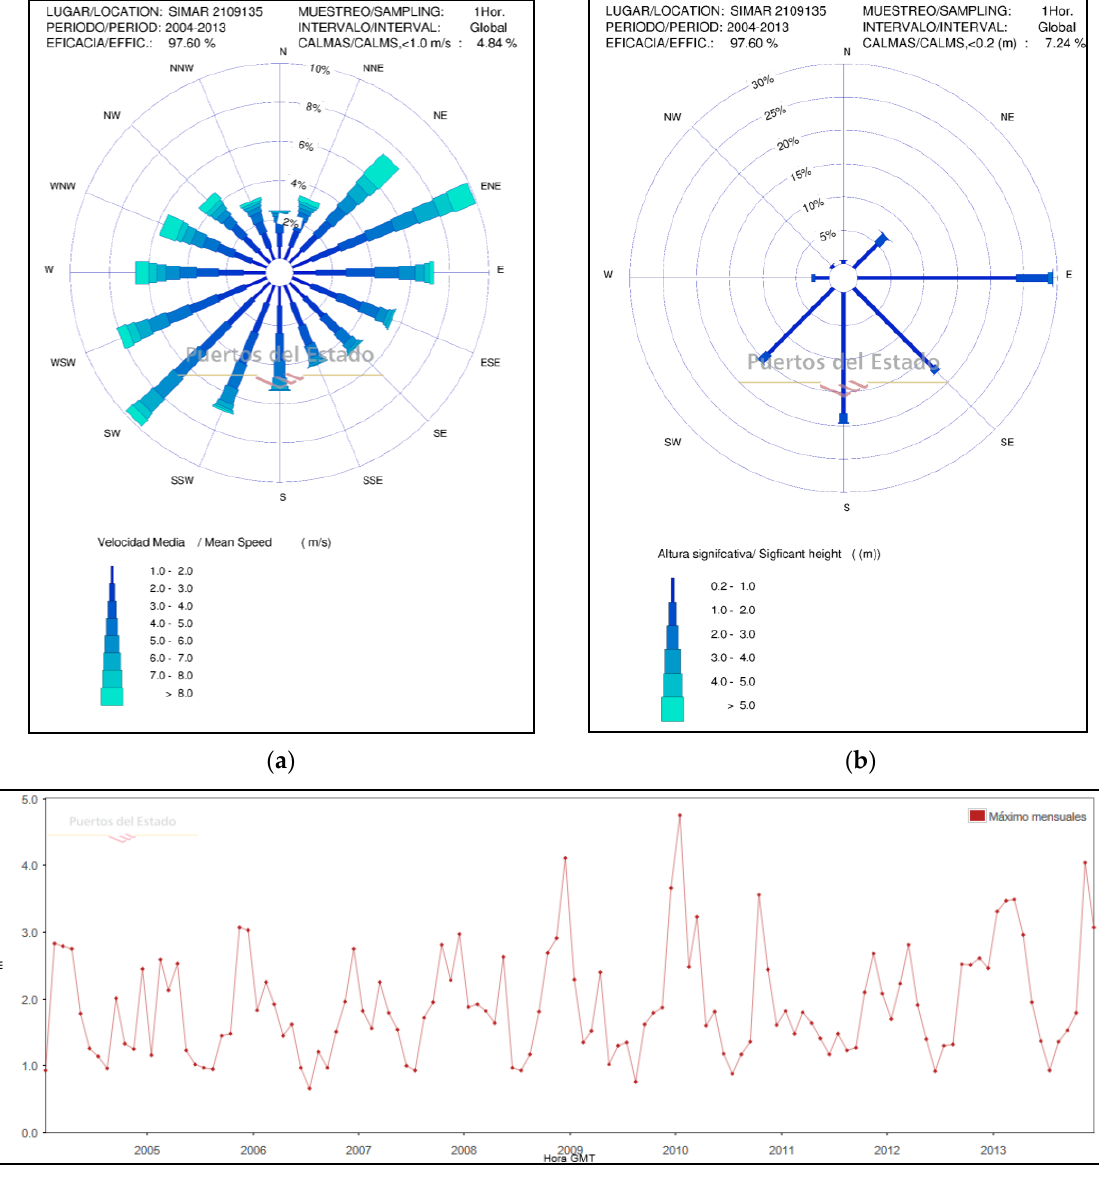
Figure 2. Meteorological data of the beach-dunes system of Remolar. The data from point SIMAR 2,109,135 (41.25 ◦ N, 2.08 ◦ E) was collected from the Puertos del Estado website (http://www.puertos.es/es-es/oceanografia/Paginas/portus.aspx) of the Ministry of Transport, Mobility and Urban Agenda. ( a ) Wind rose, between 2004 and 2013; ( b ) rose of the swell of significant height (Hs in m) between the years 2004 and 2013; and ( c ) time series of the monthly mean of the maximum significant height (Hs max. in m), between 2004 and 2013.